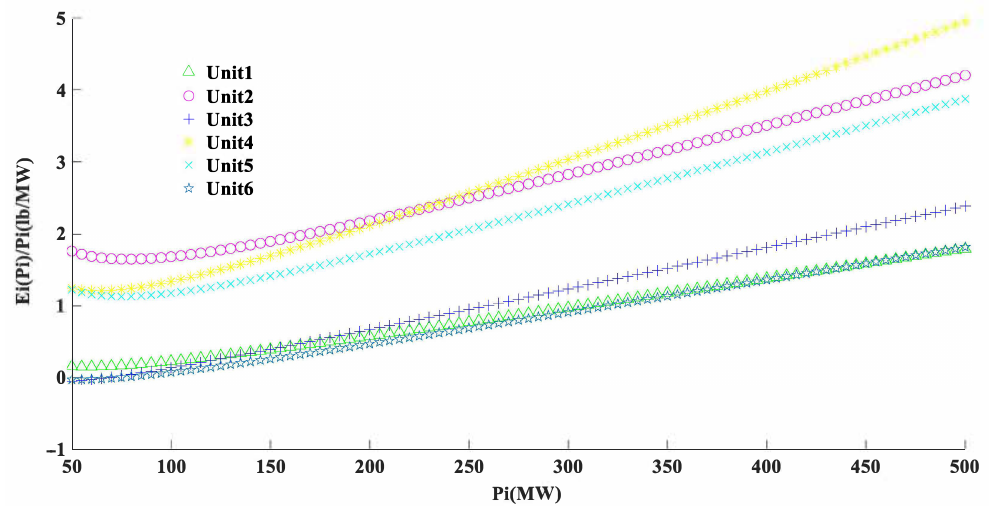
Figure 5. Unit emission between different generators.